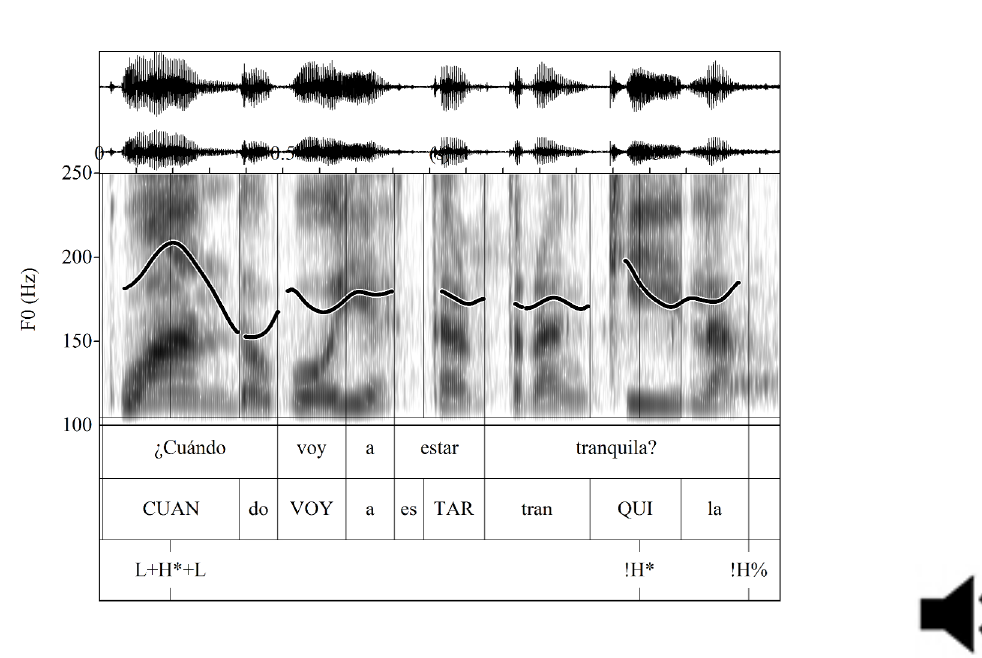
Figure 25 (Participant 4): Waveform and F0 trace for the rhetorical wh- question ¿ Cuándo voy a estar tanquilo? ‘When am I going to be left alone?’ produced as L+H*+L (in 1 st prenuclear position), deaccenting (2 nd and 3 rd prenuclear positions) and as !H* !H% (in nuclear